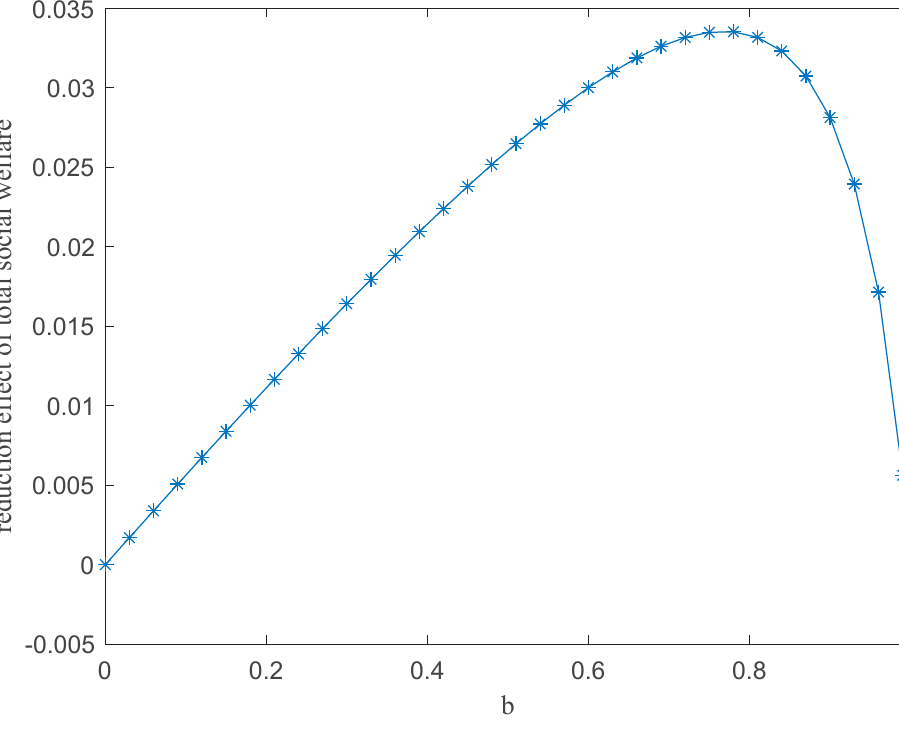
Figure 4. The reduction effect of the total social welfare.